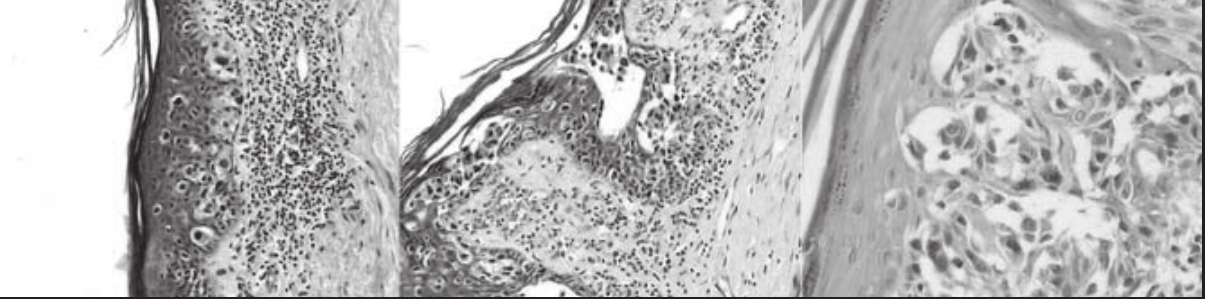
Figura 3 – Melanoma in situ , três lesões distintas (HE)